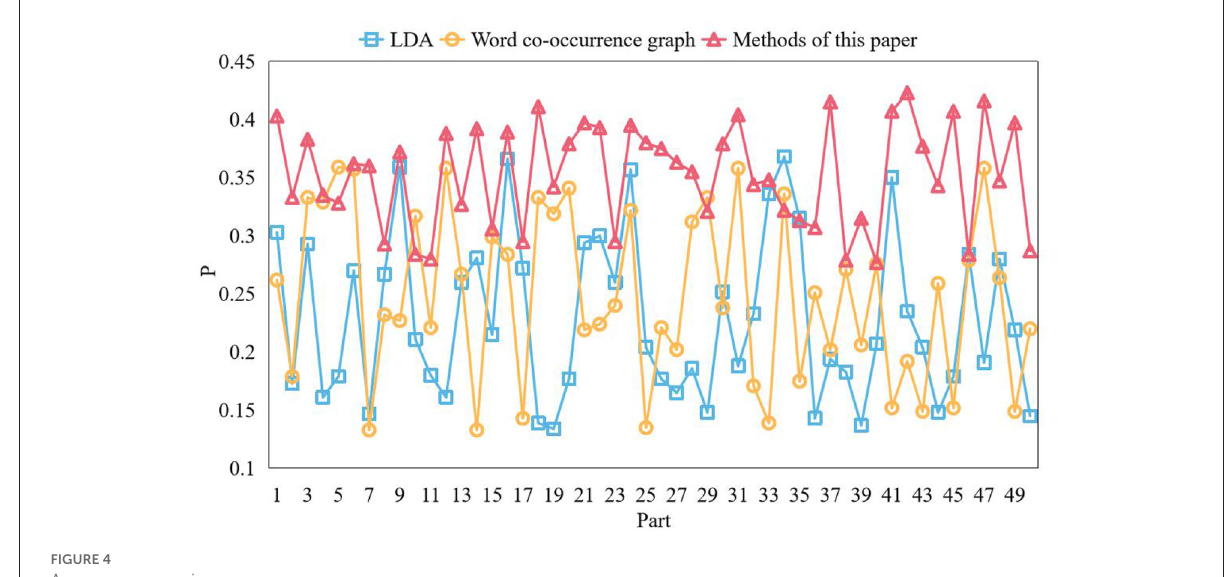
FIGURE4 Accuracy comparison.